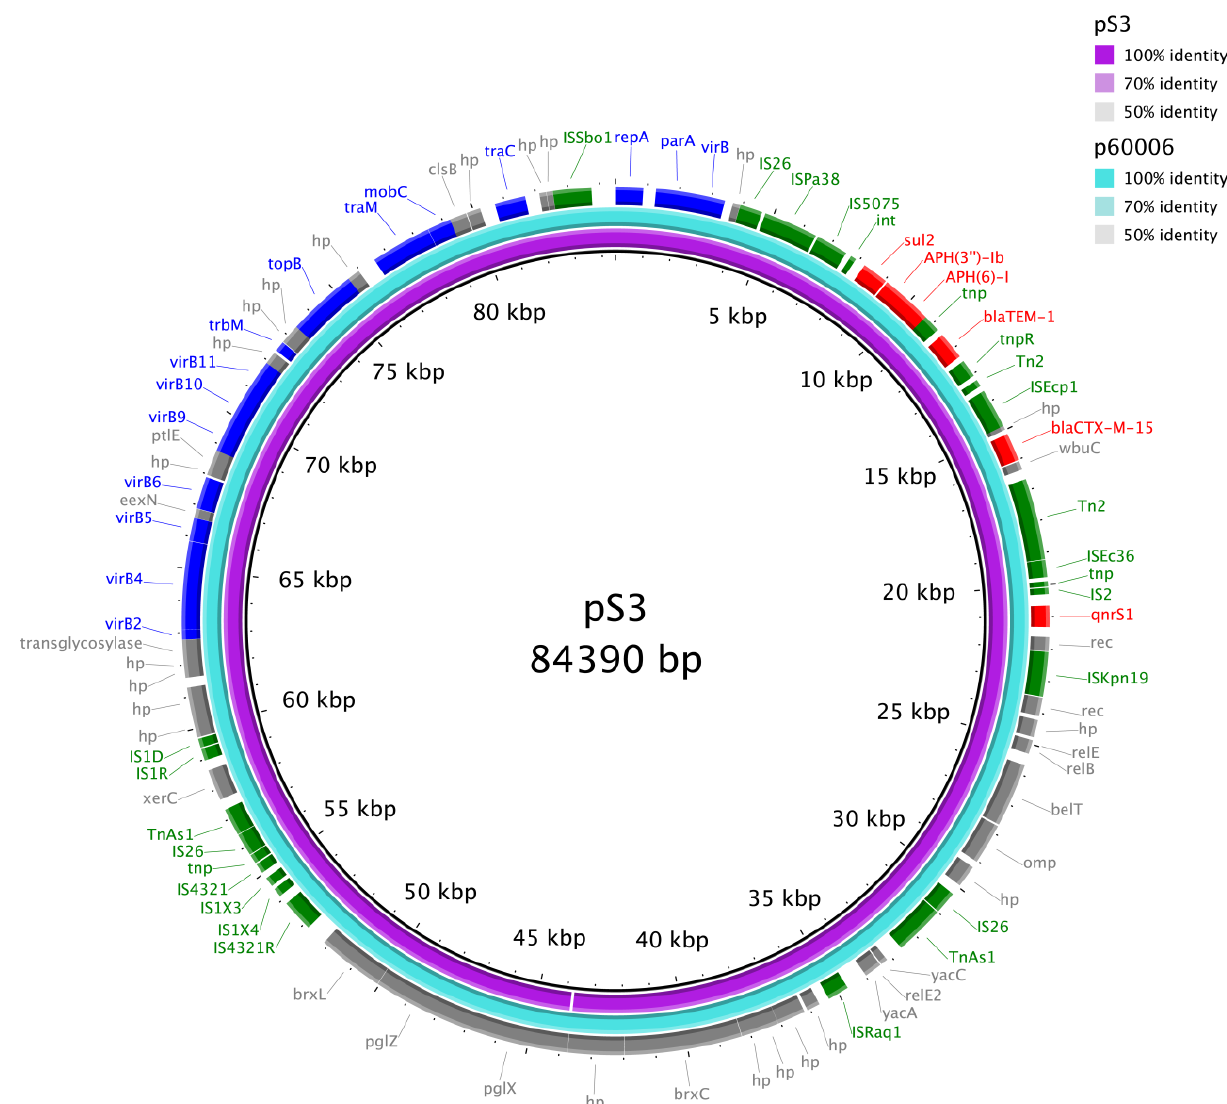
Figure 3. Alignment of the plasmid pS3 in this study with the reference plasmid p60006 using BLAST Ring Image Generator (BRIG).